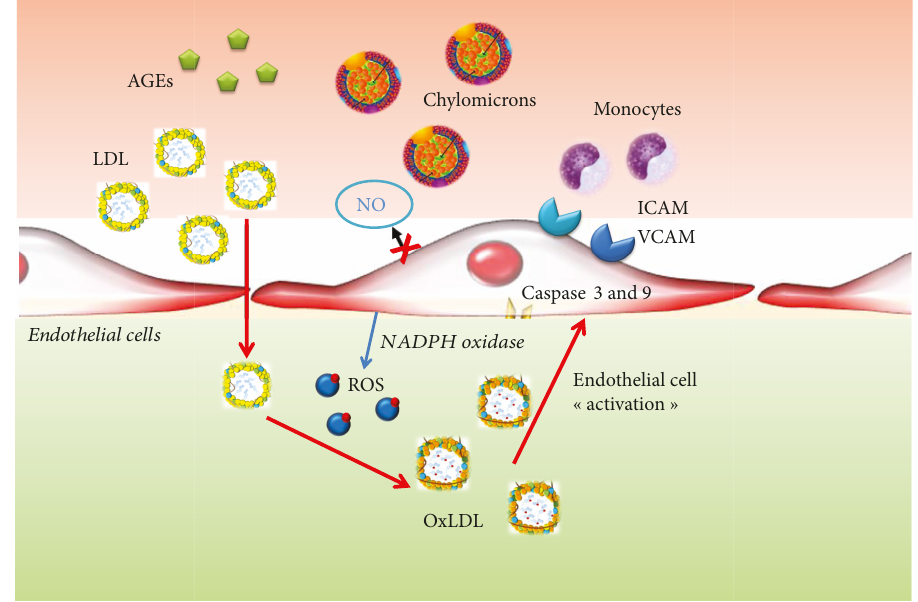
Figure 3: Role of oxidative stress in the pathogenesis of coronary artery disease and coronary microvascular